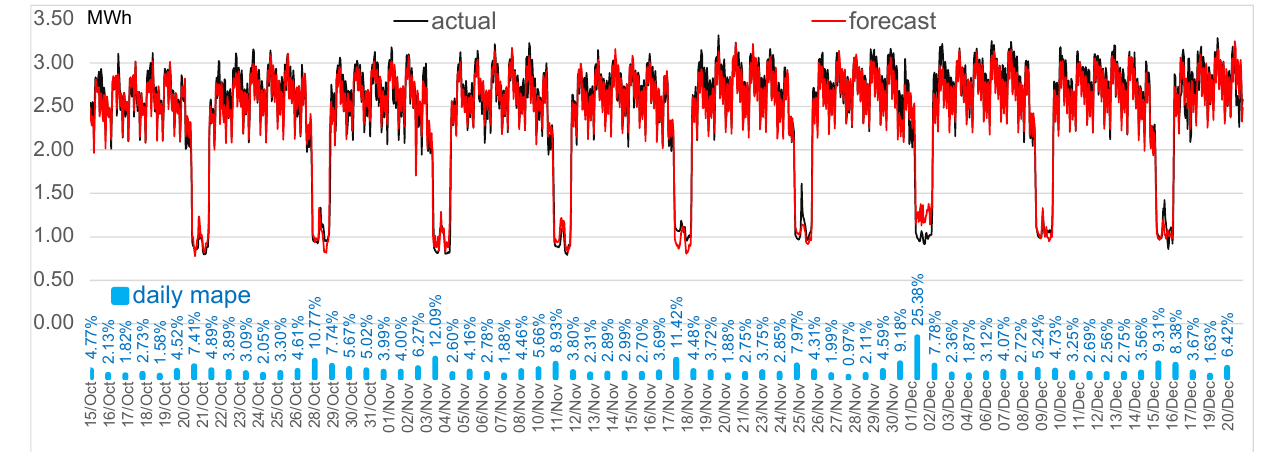
Figure 10. Forecast evaluation for the GRU implemenation.